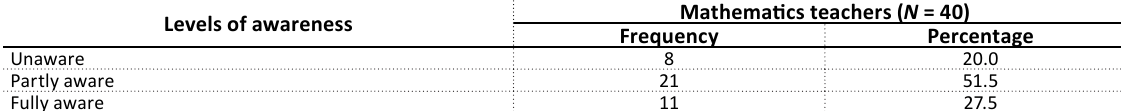
Table 7. Teacher s’ evaluation of students’ self-study awareness